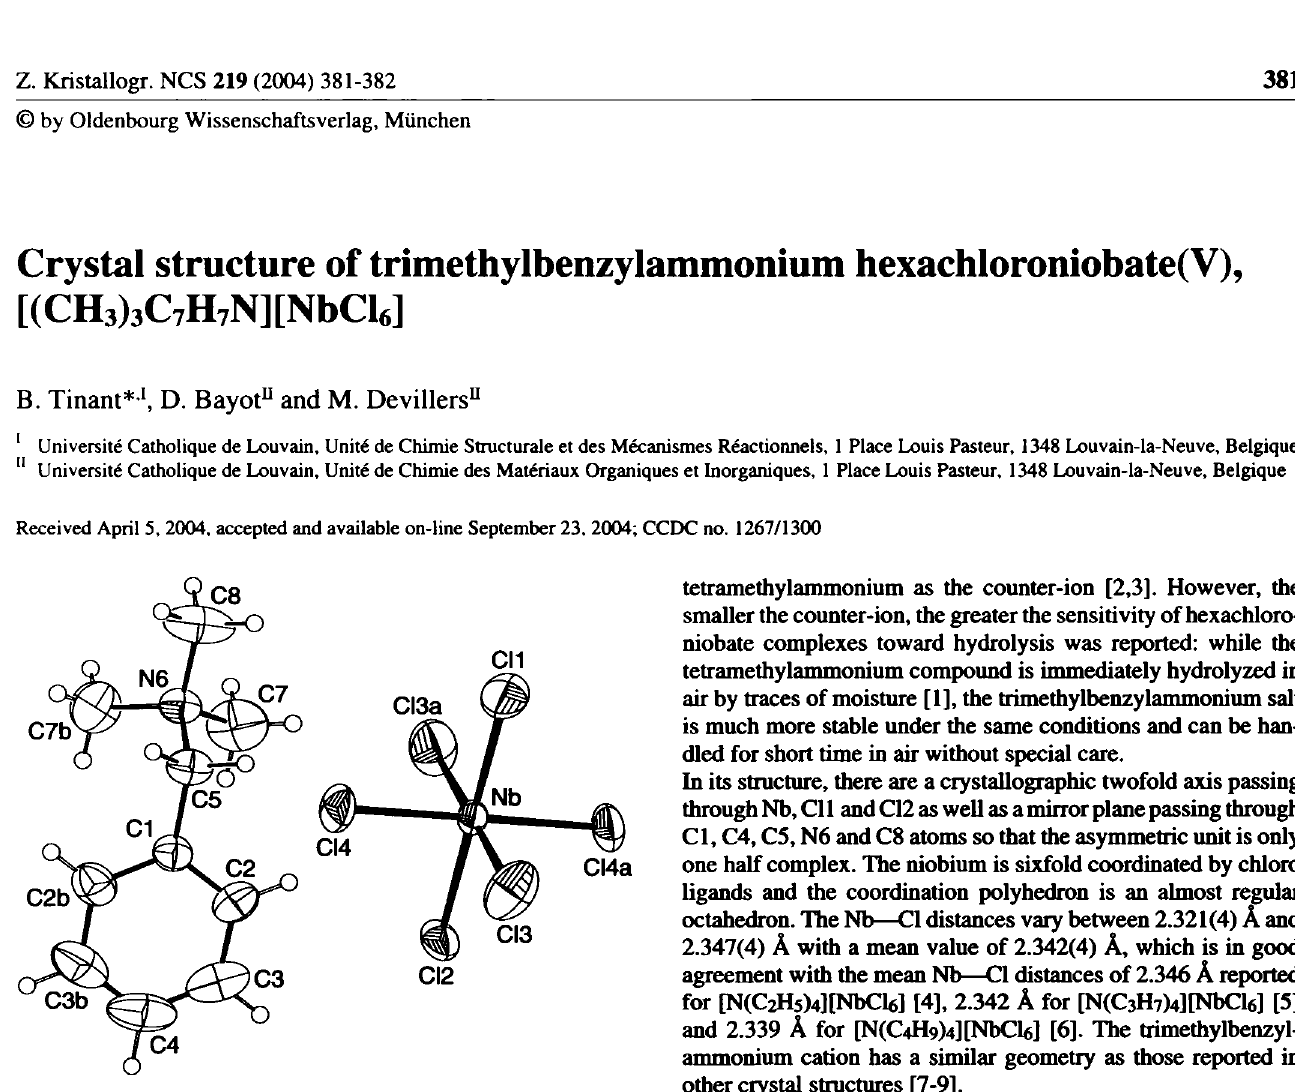
Table 1. Data collection and handling.